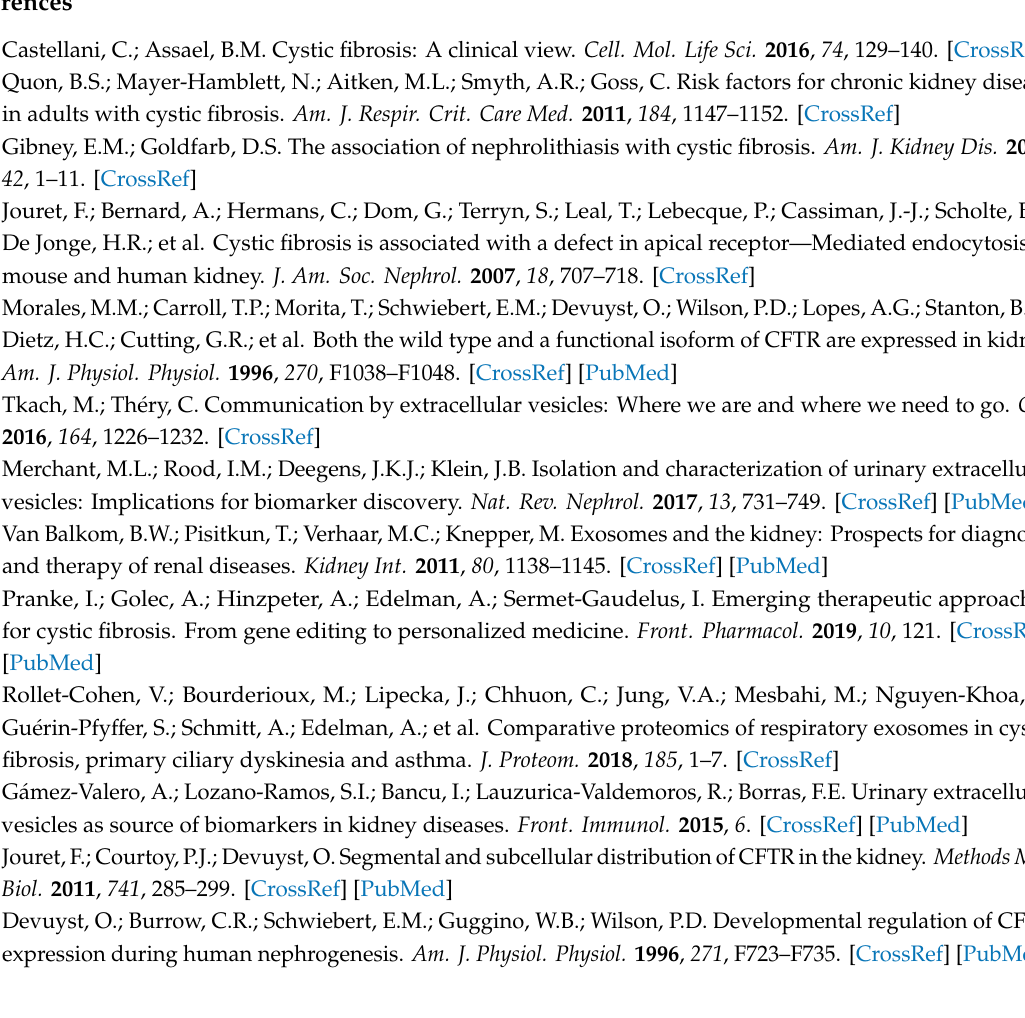
s1, Table S1: List of proteins detected in di ff erent sucrose density fractions, Table S2: Student’s T-test for control vs. CFNT vs. CFT samples, Table S3: Cellular mechanisms up-regulated and down-regulated in CF, Figure S1: Urinary exosomes are enriched and purified by density gradient fractionation, Figure S2: Dendrogram of healthy control, patient (treated and untreated) according urinary exosomal proteomic